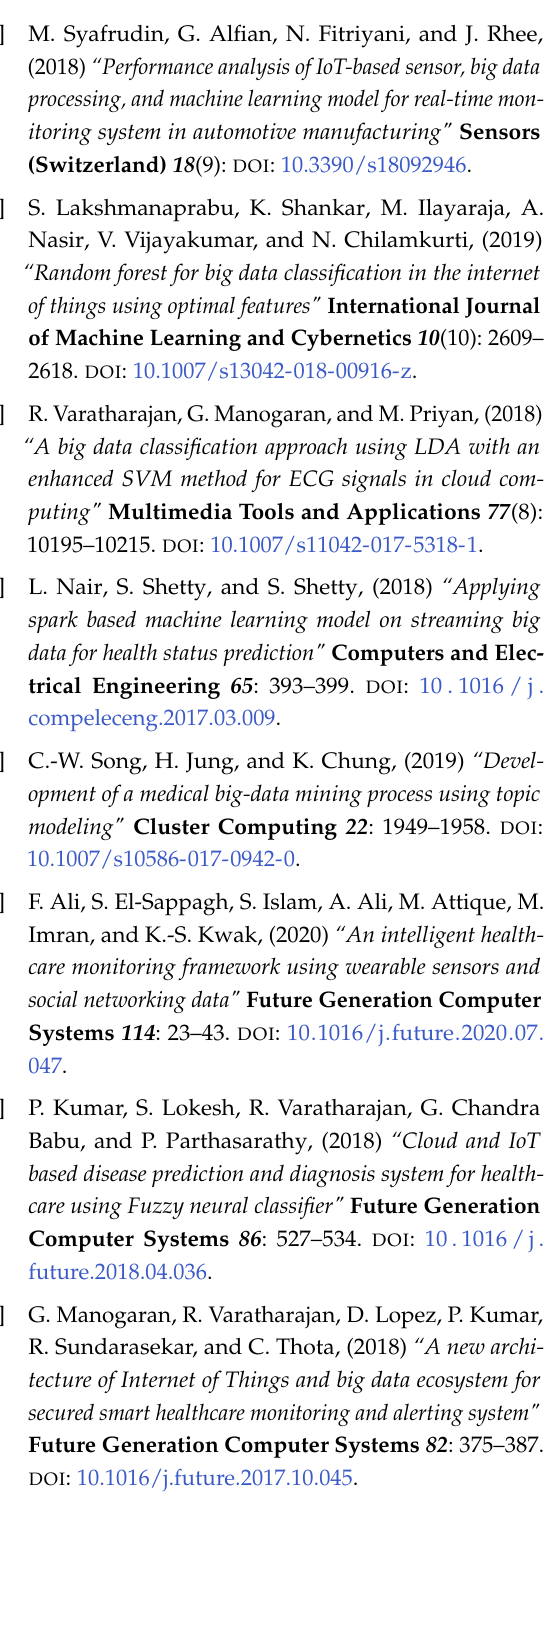
Table 5. Comparison of the Recent method with the Proposed EMACC-MR Method on the Pima Indian